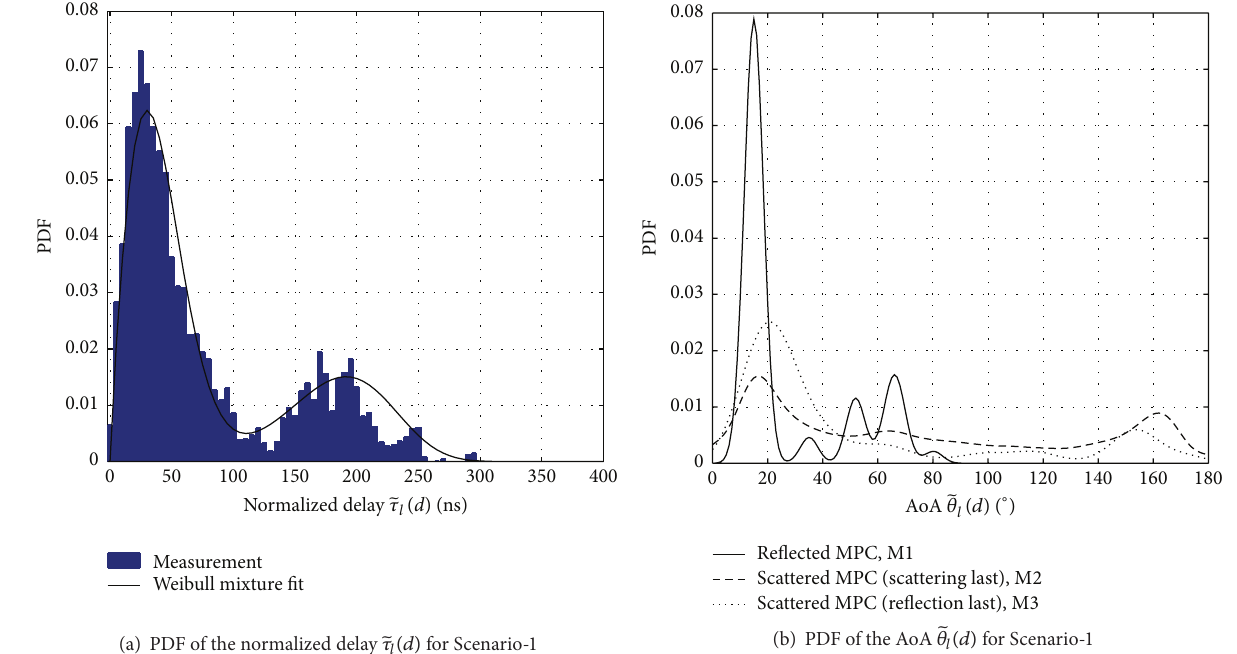
Figure 9: PDFs of delay and AoA in